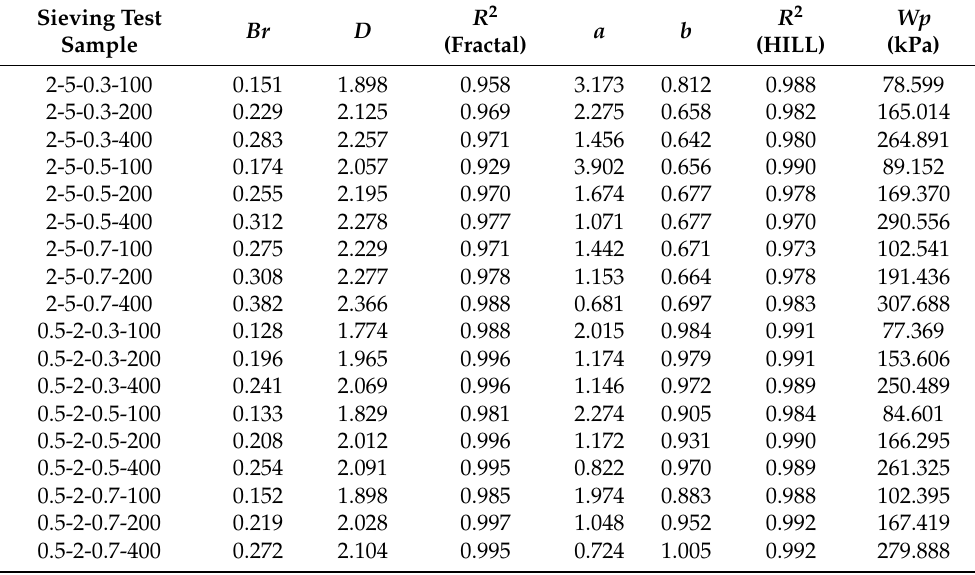
Table 4. Table of correlation coefficients and plastic work for large particle size group.